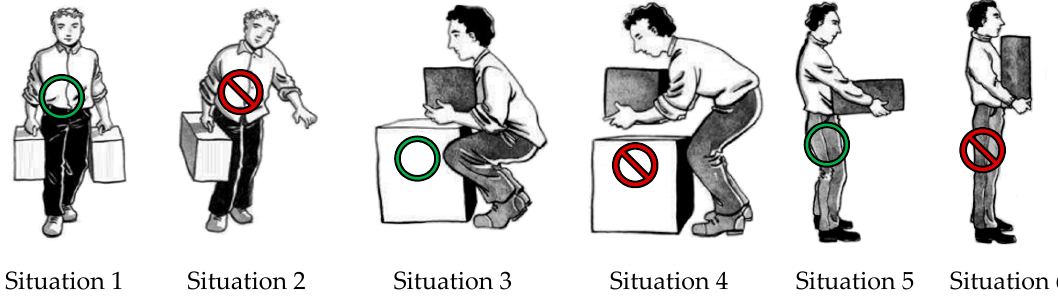
Figure 9. Six situations for evaluating adequate and inadequate posture for handling tasks, this figure is adapted from [53] with permission from Caroline Merola and the publisher.